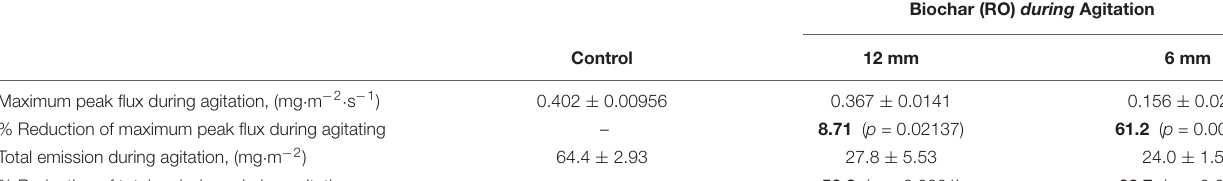
TABLE 2 | Biochar (RO) treatment: the maximum peak flux and total NH 3 emission during 3 min agitation (bold font signifies statistical significance).